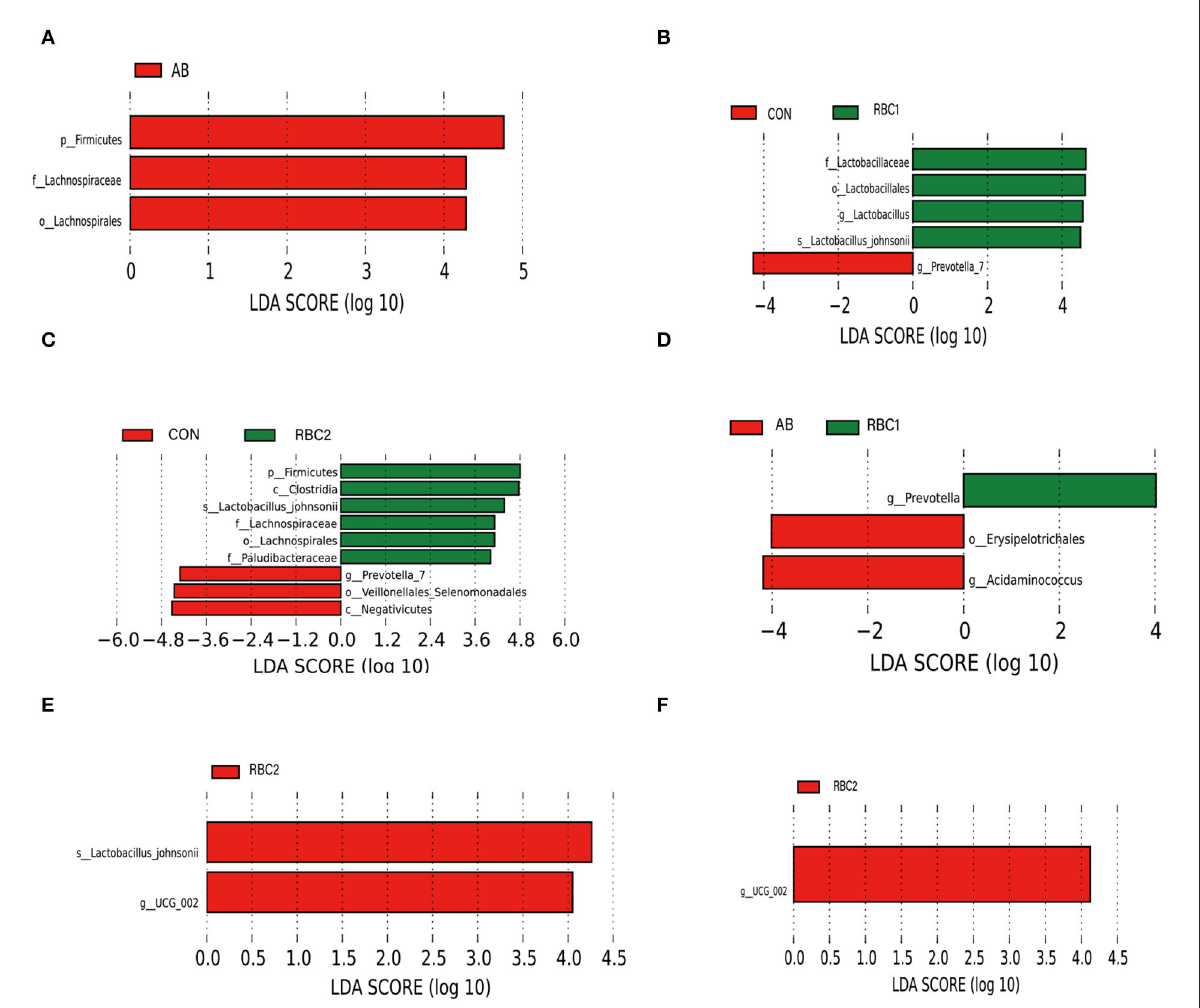
FIGURE3 LEfSe analysis of digesta microbiota. (A) CON vs. AB group, (B) CON vs. RBC1 group, (C) CON vs. RBC2 group, (D) AB vs. RBC1group, (E) AB vs. RBC2 group, (F) RBC1 vs. RBC2 group. n = 7 for each treatment. CON, basal diet; AB, basal diet + 25 mg/kg bacitracin zinc + 5 mg/kg colistin sulfate; RBC1, 5 g/kg reduction in soybean meal of basal diet + 5 g/kg RBC; RBC2, 10 g/kg reduction in soybean meal of basal diet + 10 g/kg